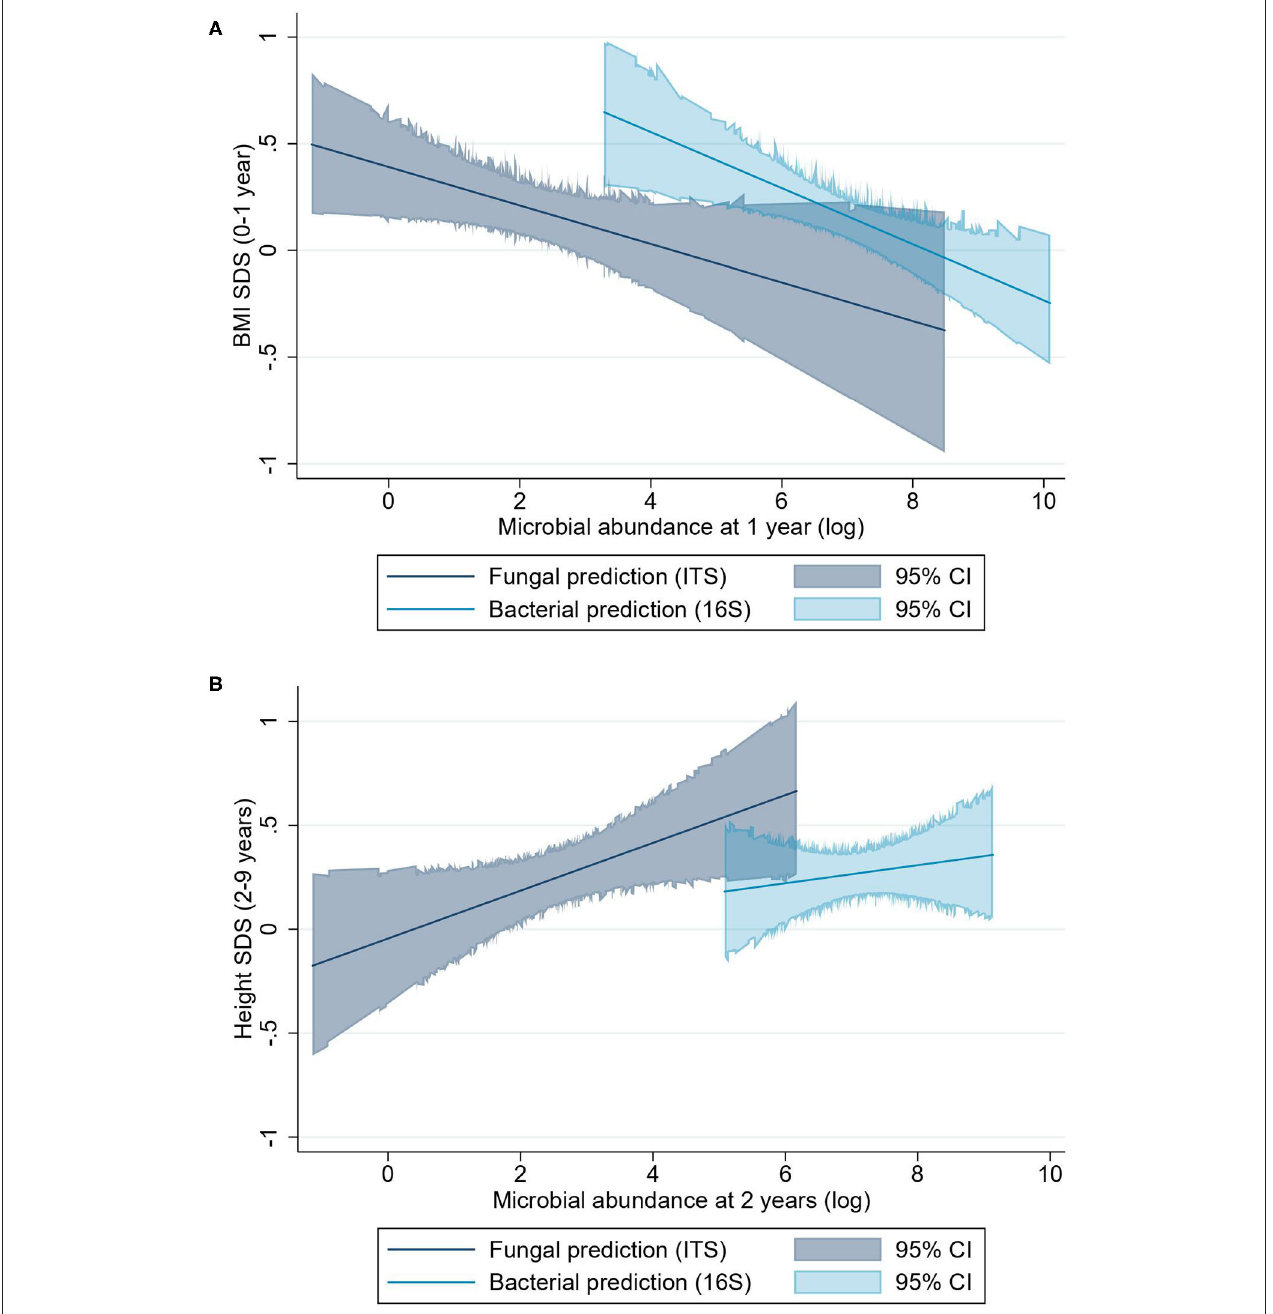
FIGURE 3 | BMI-SDS and height-SDS and microbial abundance as predicted linear associations. (A) Predictions of BMI-SDS at 0–1 year for fungal and bacterial abundances. (B) Prediction of height-SDS at 2–9 years for fungal and bacterial abundance. The predictions are shown as lines, and the colored areas cover the 95% CI. The bacterial abundance prediction model for height-SDS remains statistically